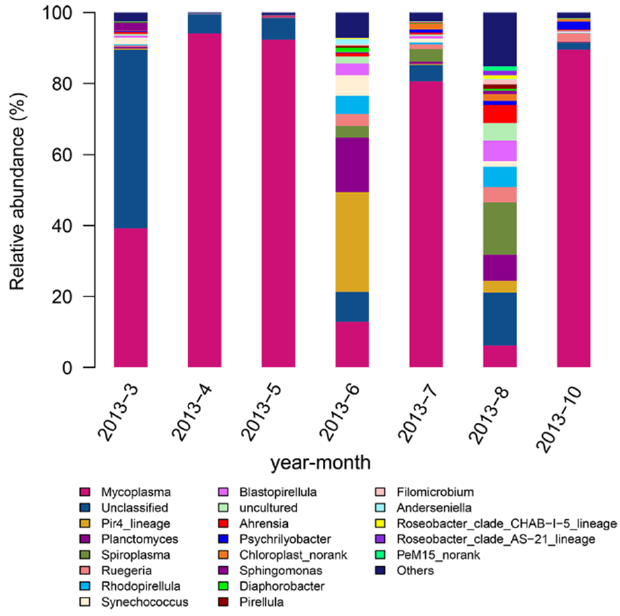
Figure 4. Genus-level abundance of bacterial community in the intestine of abalone cultured in the open sea area in different months.